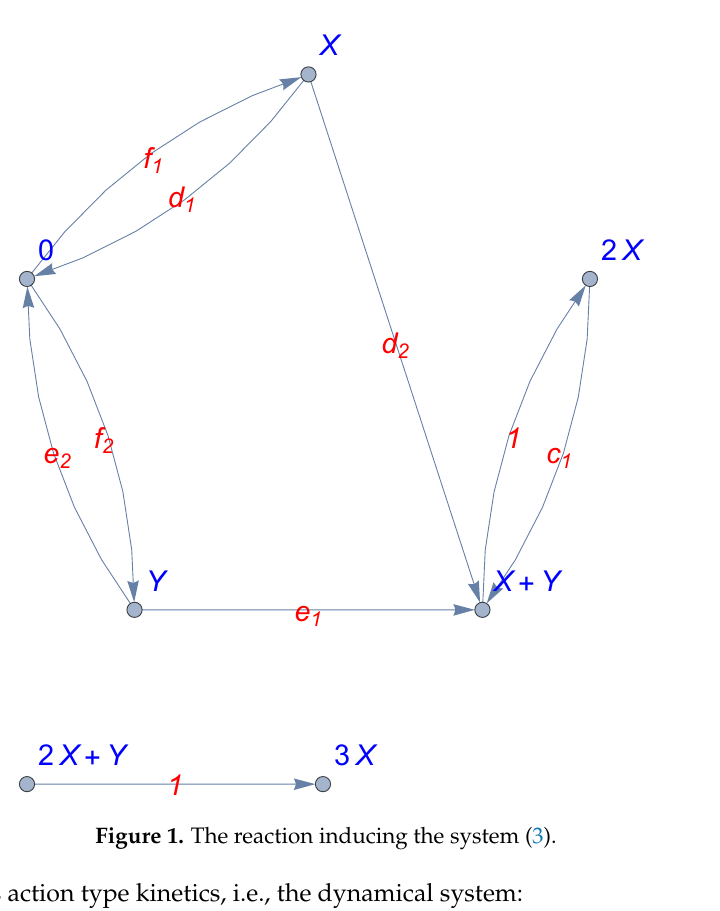
Figure 1. The reaction inducing the system